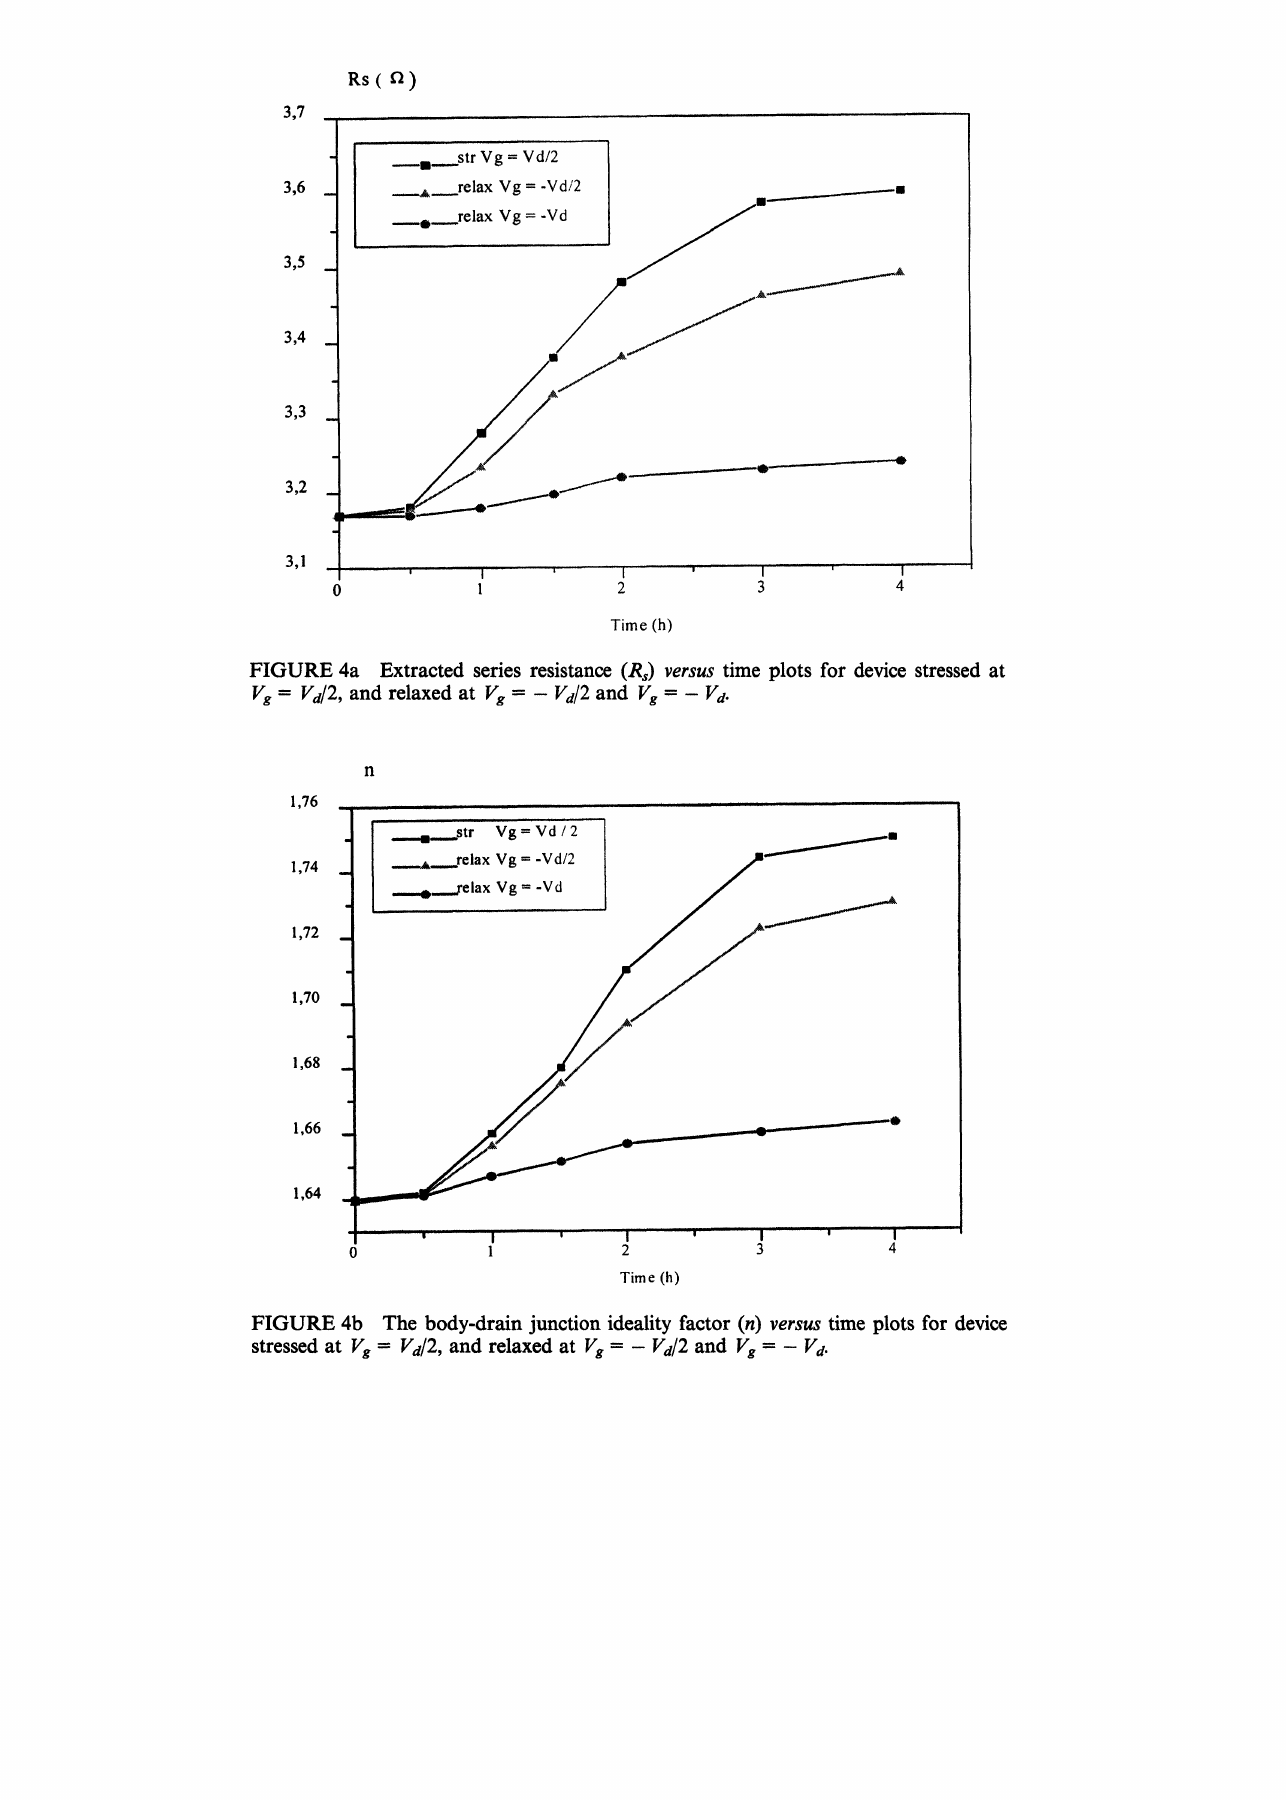
FIGURE 4b The body-drain junction ideality factor (n) versus time plots for device stressed at l/’g I"d/2, and relaxed at lg l"d/2